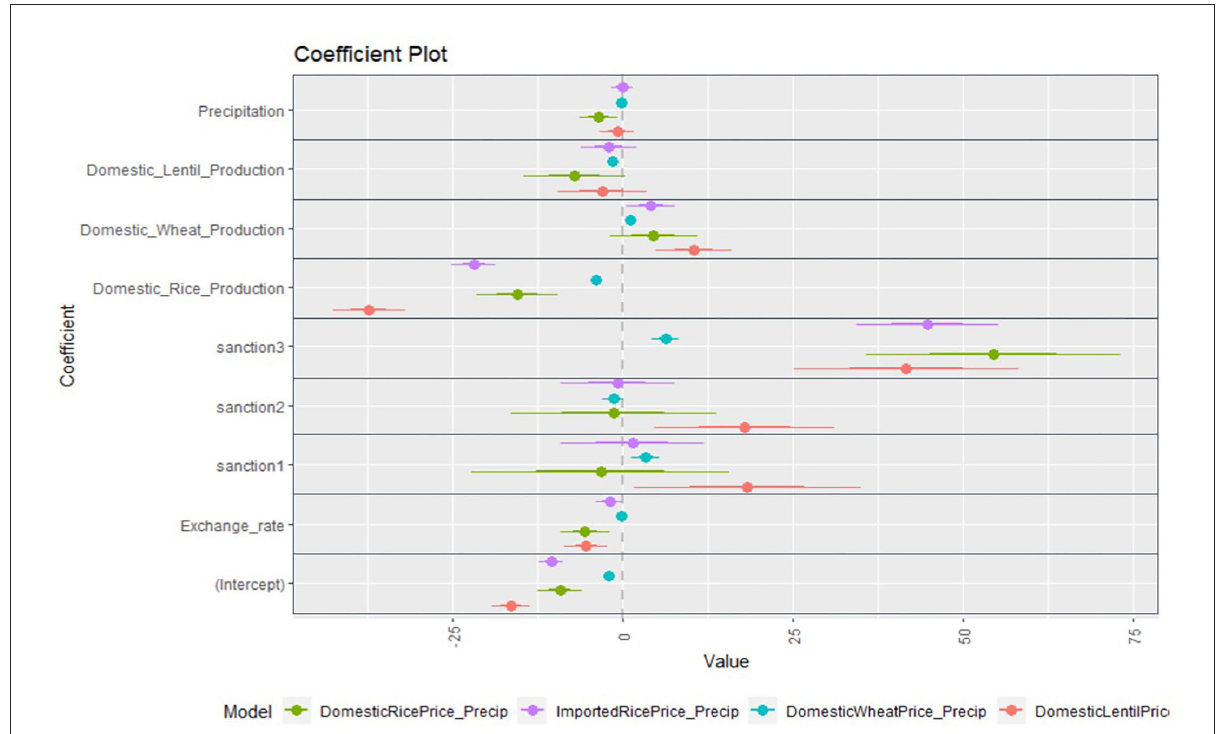
FIGURE10 Linear regression results for detrended values including precipitation and based on the regression